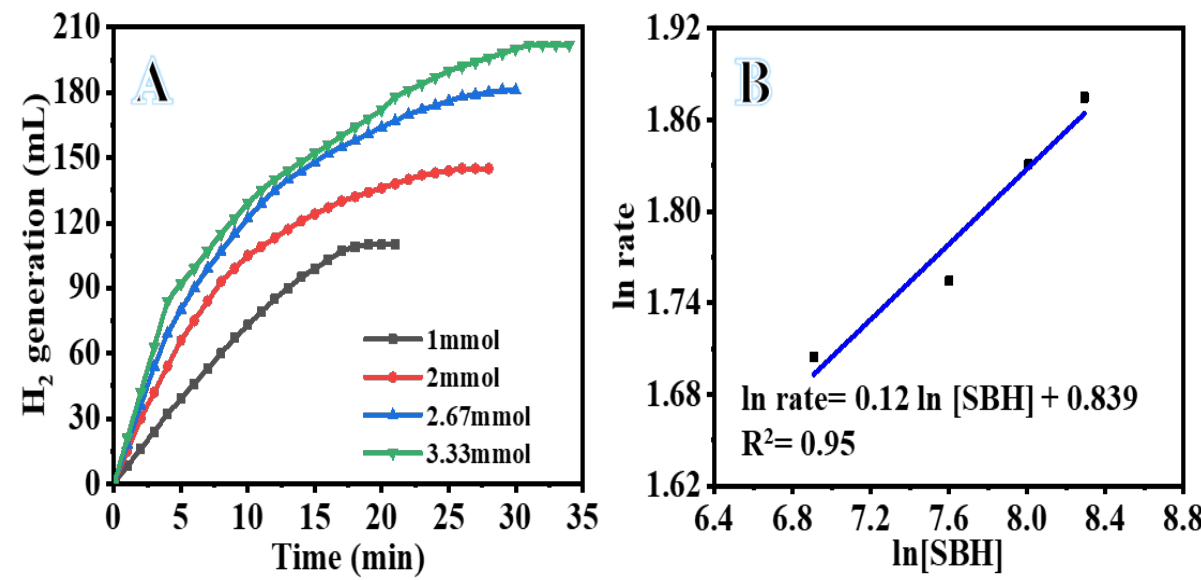
Figure 8. The influence of SBH concentration on the dehydrogenation process ( A ) and ln H 2 generation rate vs. ln [SBH] ( B ). The amount of catalyst = 100 mg and T = 298 K.